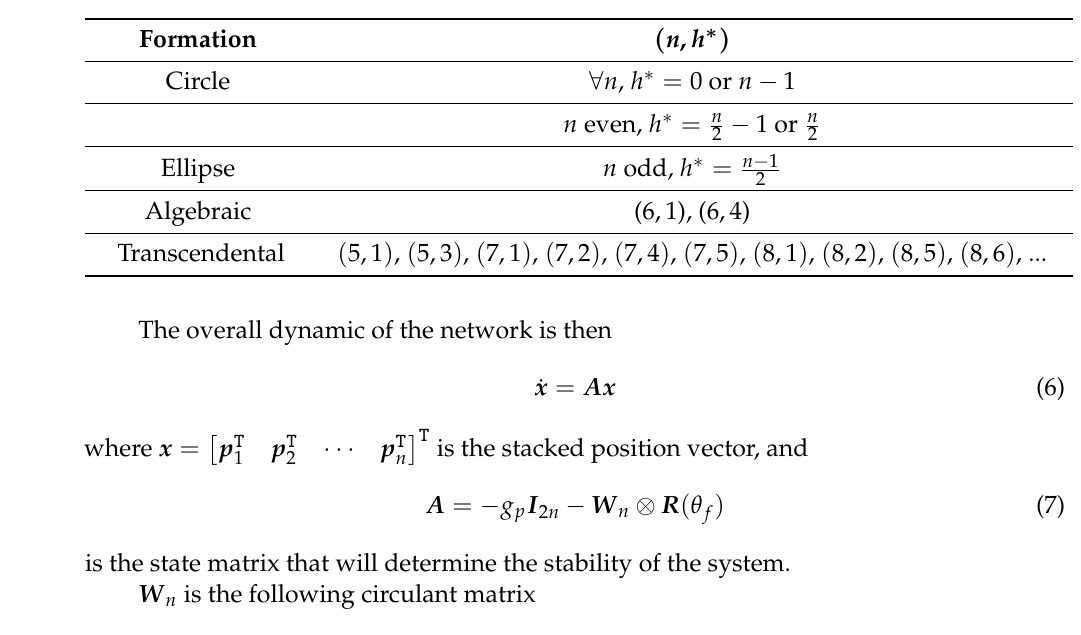
Table 1. Relationship between the patterns and ( n , h ∗